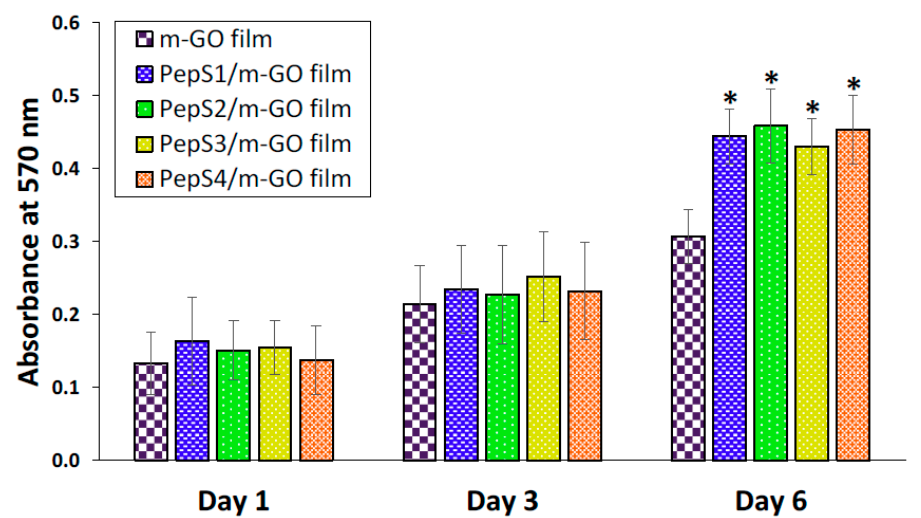
Figure 3. Cell viability of the WJ-MSCs evaluated at the m-GO film before and after conjugate with peptide sequences (PepS1, PepS2, PepS3, and PepS4) was quantified by MTT assay. WJ-MSCs were seeded in a 48-well plate at a density of 1 × 10 4 cells/well for 6 days. The error bars represent the SD about the mean. Asterisk (*) indicates statistical significance ( p < 0.05) compared with the m-GO film on the same day.